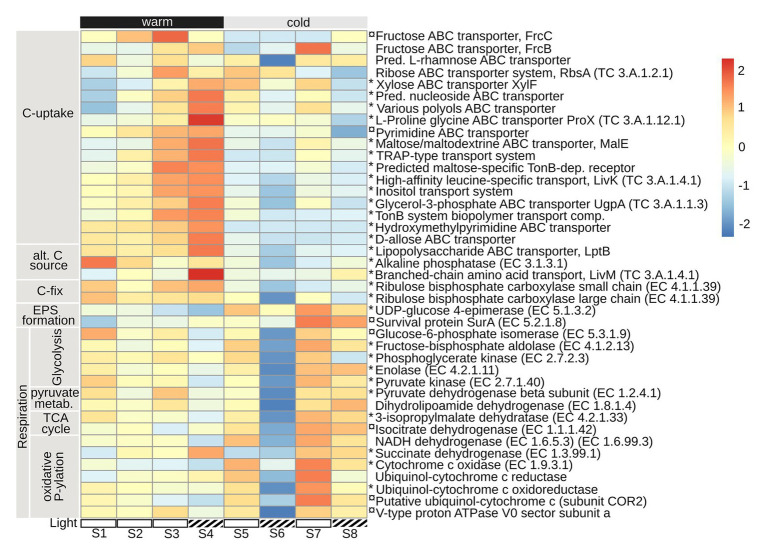
Prokaryote gene expression (excluding transcripts annotated as eukaryotes in the prokaryotic dataset) of mechanisms associated with carbon acquisition, putative extracellular polysaccharide (EPS) formation, and respiration. Included are key enzymes representative of: carbon uptake (C-uptake), alternative carbon sources, carbon fixation, EPS-formation, glycolysis, pyruvate metabolism, tricarboxylic acid (TCA) cycle, and oxidative phosphorylation. Heatmap shows the mean of triplicates per sampling date (S1–S8), normalized to TPM and square-root transformed, made using R package pheatmap, with setting scale by “row.” Warm: 19.5 ± 0.89°C, cold: 12.4 ± 1.76°C (mean temperature per 24 h in PBR); Light: light reduction, open bar → natural light, striped bar → light reduced by 40–60% by shading. * indicate padj < 0.01, and ¤ padj < 0.05, for log2 fold change, differential expression, contrasted for warm vs. cold time period.